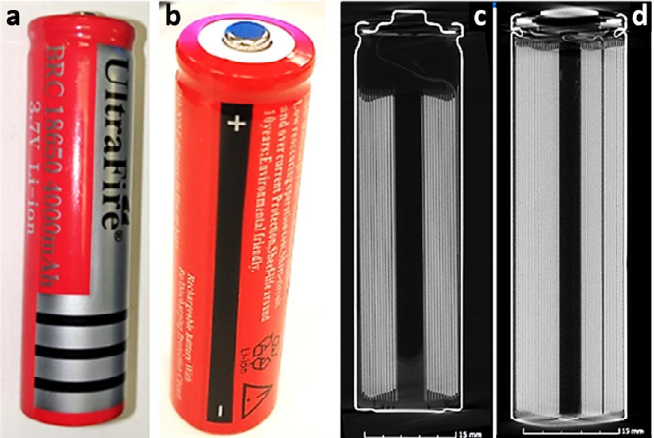
Figure 3. Counterfeit 18650 battery with a label of ( a ) exaggerated capacity of 4000 mAh and ( b ) misspelled words. Under X-ray computed tomography, ( c ) the counterfeit battery shows a shorter internal “jelly roll” than the ( d ) genuine product [37]. (Images courtesy of DfR Solutions, reproduced with permission.)